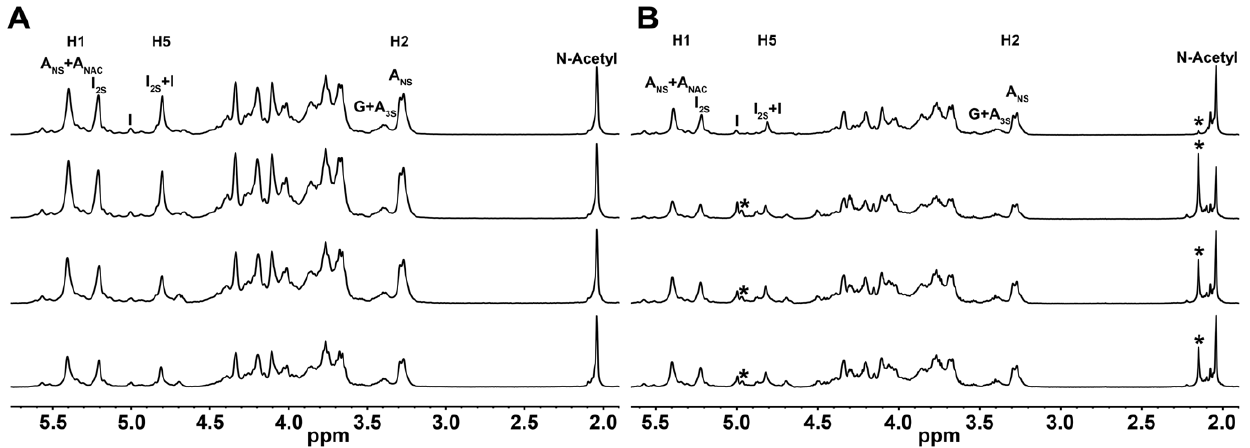
Figure 1. NMR analysis of heparin samples. ( A ) 1 H NMR spectra of pure heparin samples. ( B ) 1 H NMR spectra of contaminated heparin samples. From bottom to top samples a, b, c and d ( A ) and e, f, g and h ( B ). Signals due to the contaminants are highlighted by asterisks. A NS , 2-deoxy-2- sulfoamino-D-glucopyranose; A 3S , 2-deoxy-3-O-sulfo-2-amino-D-glucopyranose; A NAC , 2-deoxy-2-acetylamino-D-glucopyranose; I 2S , 2-O-sulfo- iduronic acid; G, glucuronic acid; I, iduronic acid.